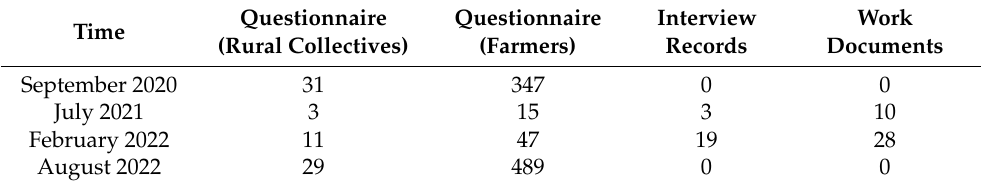
Table 2. The data obtained by the field research of this study group. Questionnaire Time (Rural Collectives)